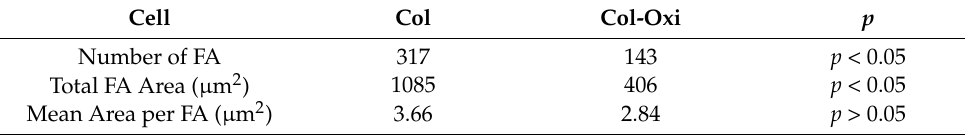
Table 2. Focal adhesion formation: number of FA, total area of FA, and mean area per FA. Cell Col Col-Oxi